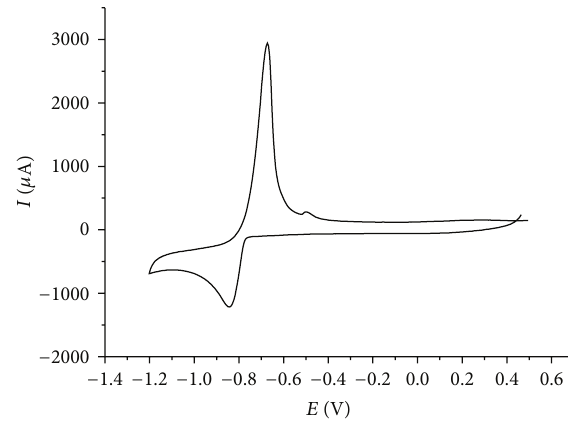
Figure 2: Cyclic polarization curves of Tl + ( 𝑐 = 10 −3 mol L −1 ) on glassy carbon electrode at different scan rates in the presence of oxygen (air saturated solutions). The electrolyte was 0.5 molL −1 Na 2 SO 4 , pH = 7. (1) 50 mV/s; (2) 20 mV/s; (3) 10mV/s; (4) 5 mV/s.